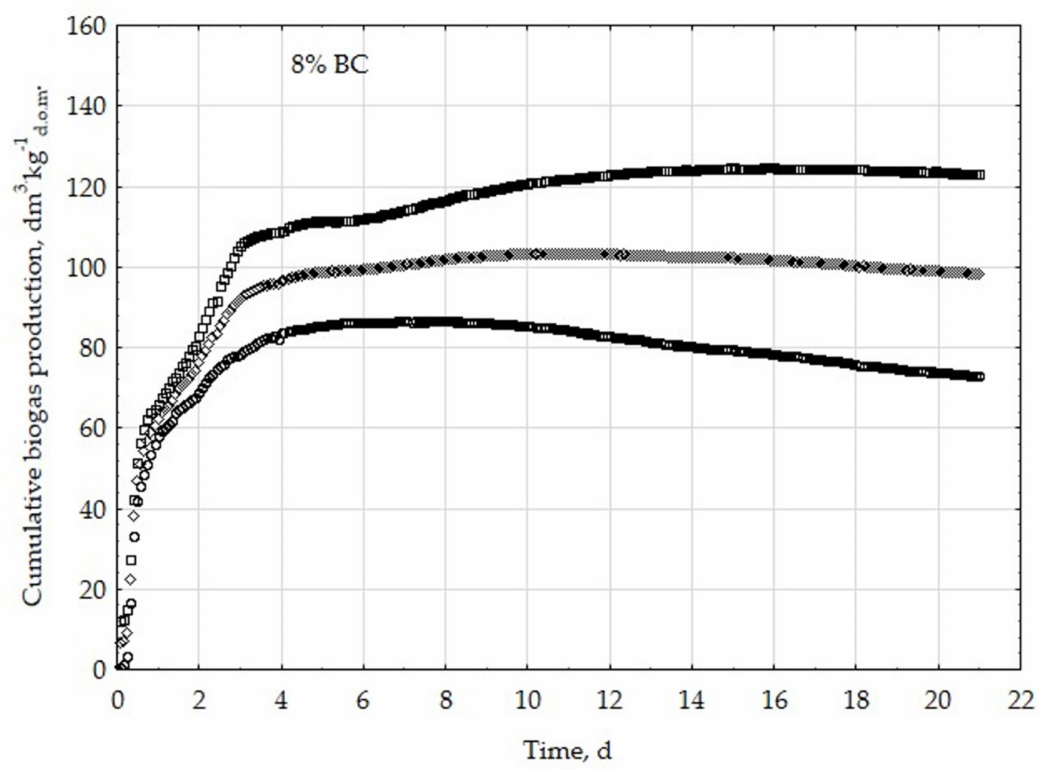
Figure A5. Biogas production from BSG: cumulative curves in variant with biochar addition at the level of 8%. The number of repetitions was three.